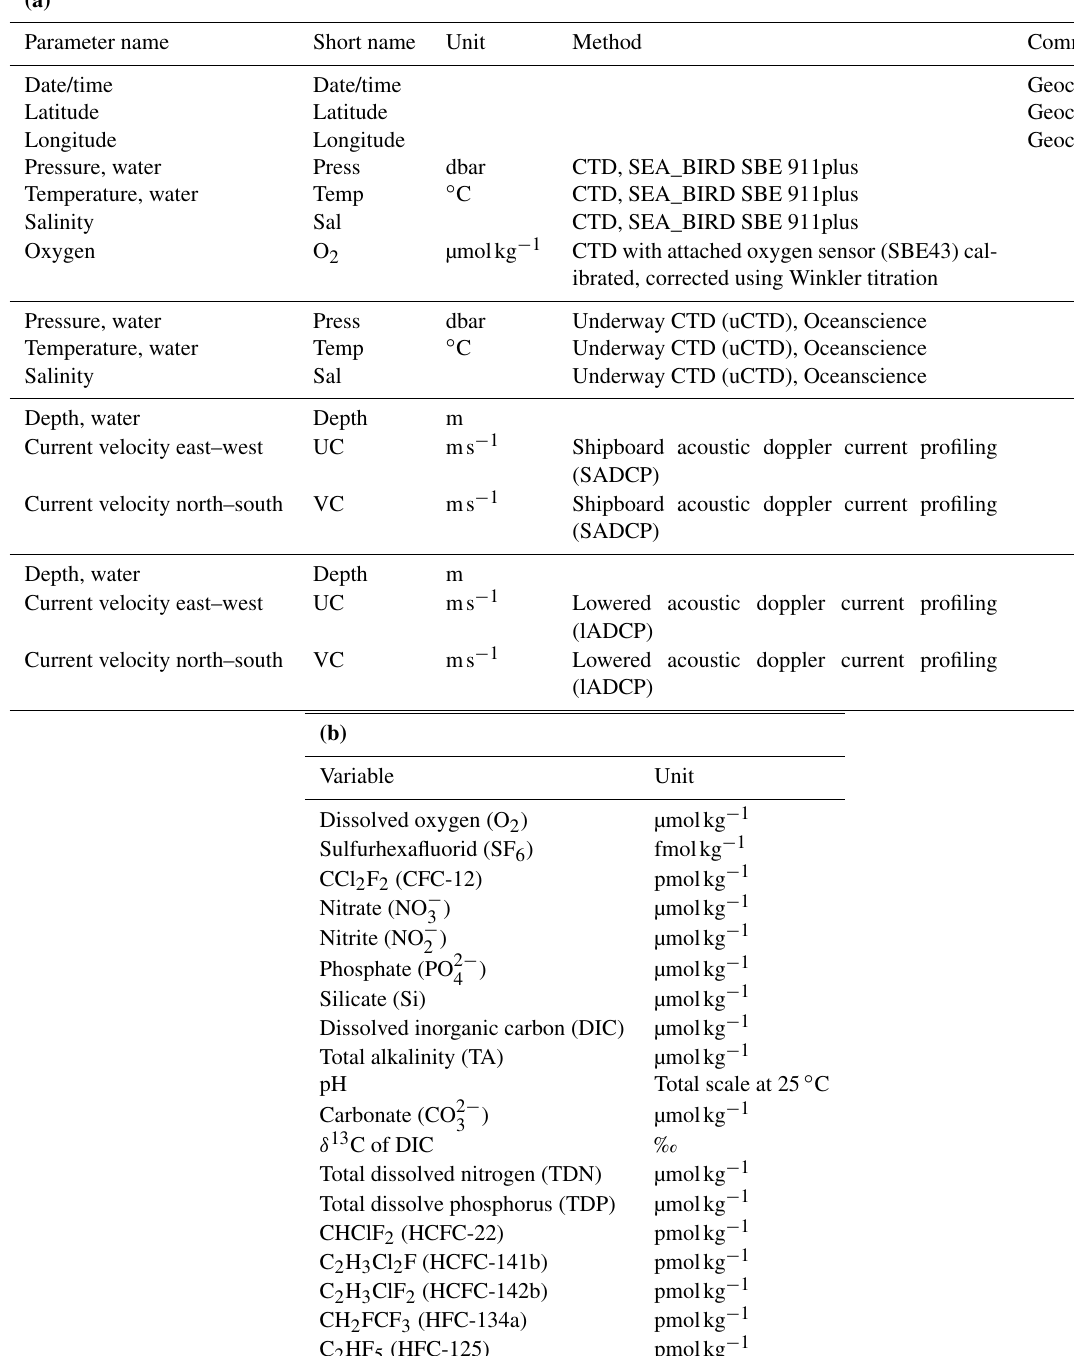
Table 1. (a) List of physical parameters from Maria S. Merian cruise MSM72 as seen in the PANGAEA database. The primary investigator was Dagmar Hainbucher. (b) List of biogeochemical parameters from Maria S. Merian cruise MSM72 as seen in the CCHDO database. The primary investigator was Toste Tanhua. (c) List of available data